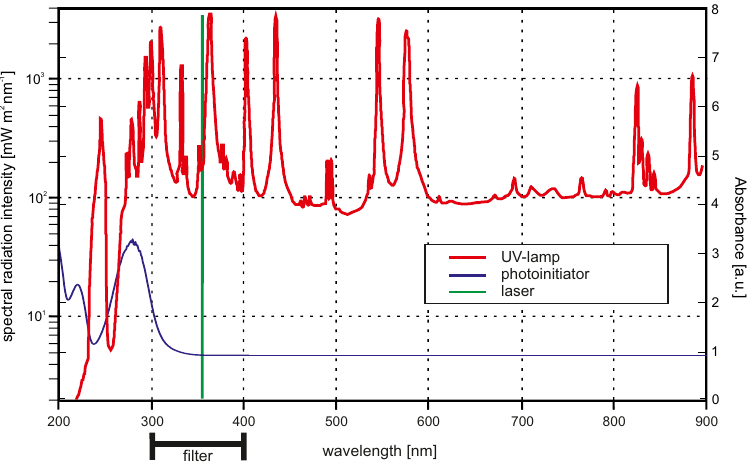
Figure 2. Plot of the spectral radiation intensity at 0.5m proximity of the mercury-vapour lamp is demonstrated including the UV/Vis spectrum of the photoinitiator Irgacure R (cid:13) . The green line sketches the wavelength of the laser with no respect to one of the y-axes. The lamp spectra was reprinted from the lamp datasheet with kindly permission from LOT-Oriel Group